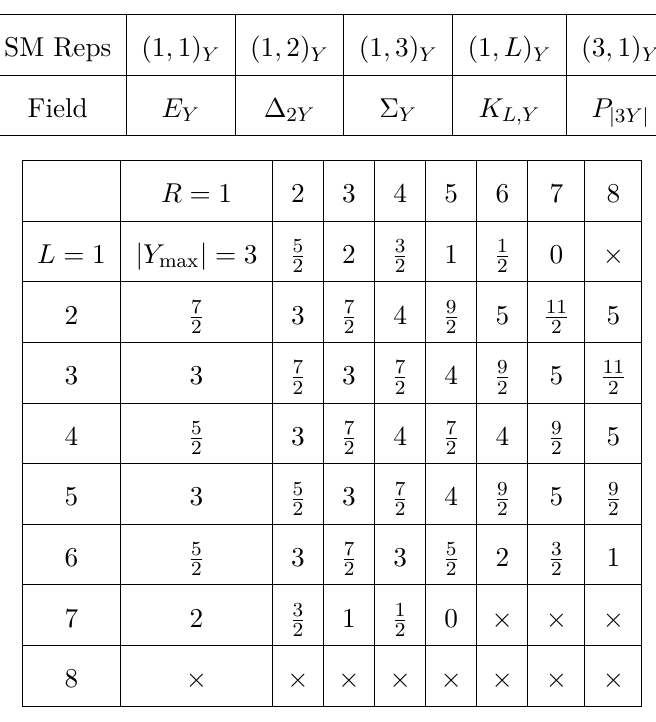
Table 2 . The representations and corresponding fields for the vector-like fermionic BSM Loryons considered in this work. We express “SM charges” as ( C, L ) and “custodial charges” as [ L, R ] ; the Y Y custodial representation [ L, R ] contains SM fields ( C, L ) to ( C, L ) in steps of Y − ( R − 1) / 2+ Y ( R − 1) / 2+ Y unit hypercharge. Hypercharges Y are restricted so that any new charged particles can promptly decay and so that the Yukawa terms with the Higgs are gauge